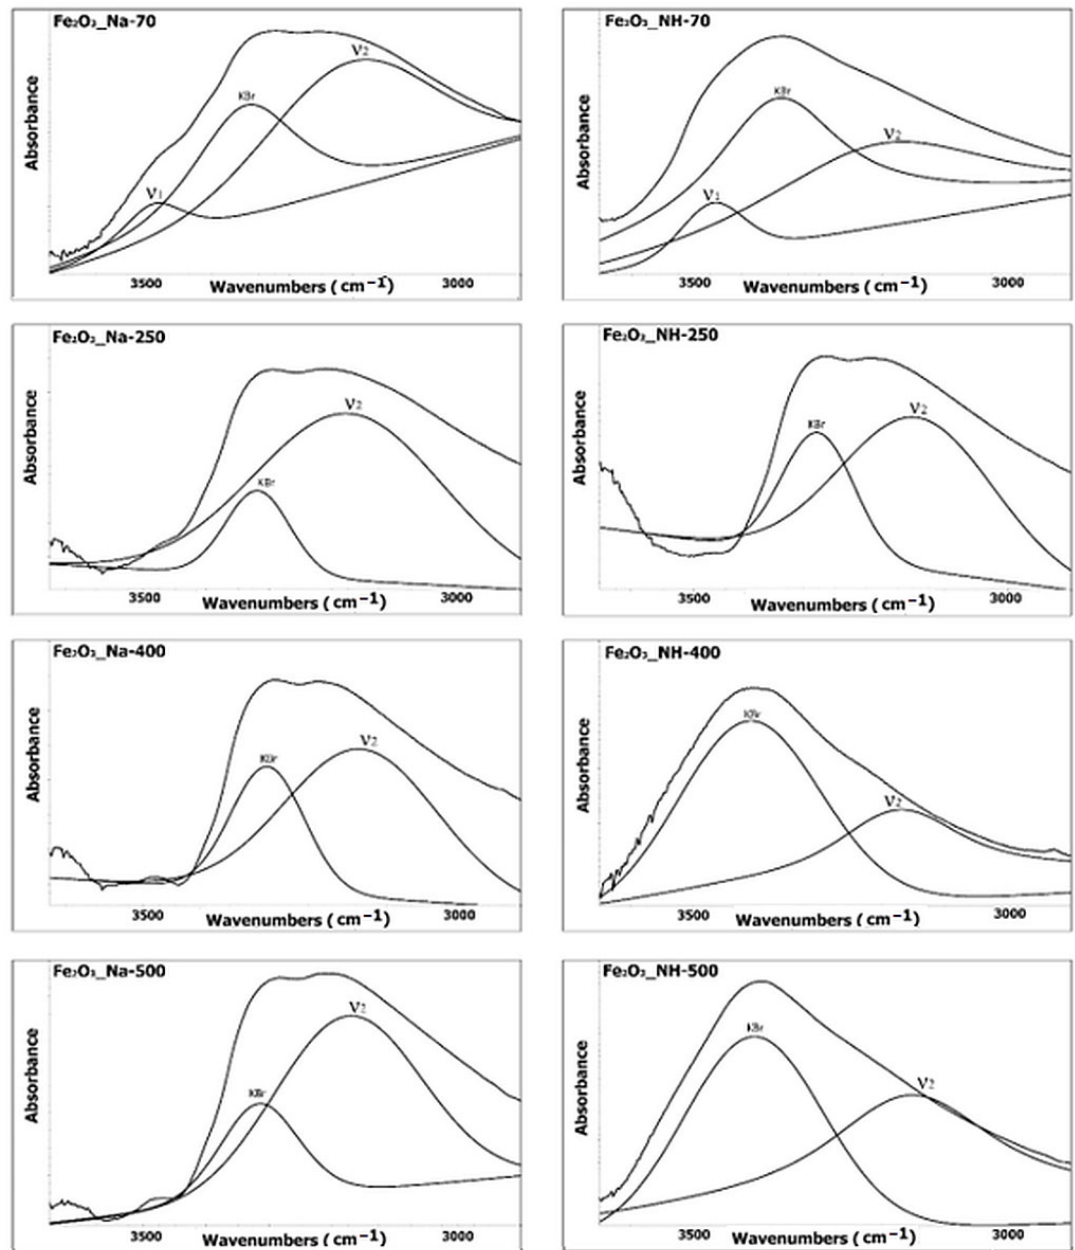
Figure 7. IR spectral bands above 3000 cm − 1 comprise the stretching vibration regions of water ( ν 1) and hydroxyls ( ν 2).